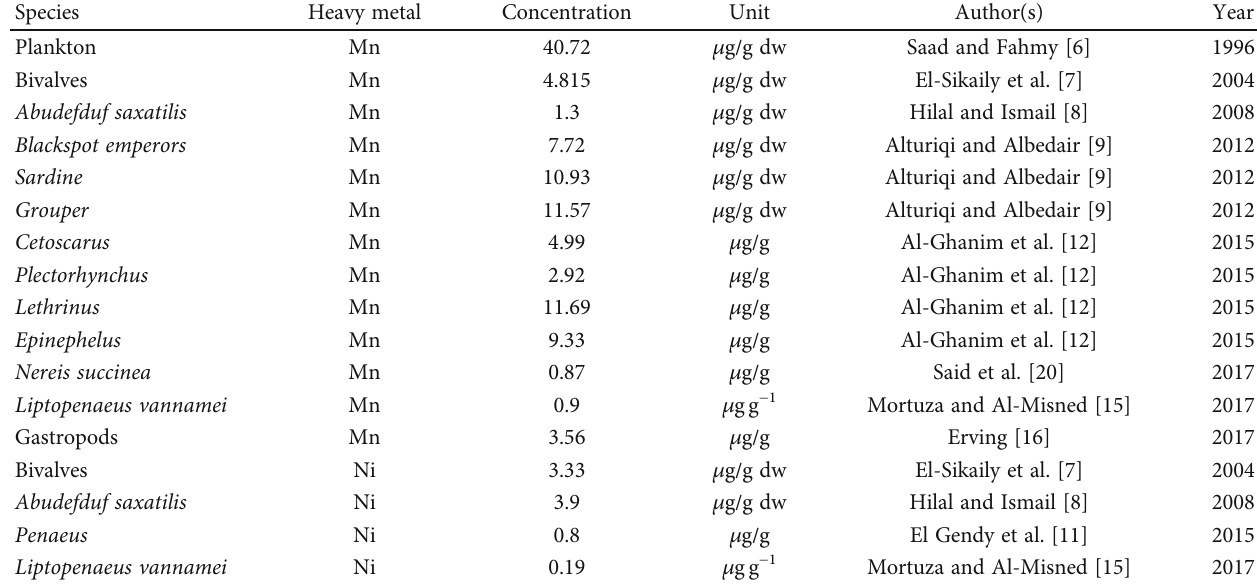
Table 3: Bioaccumulation of manganese and nickel reported from the Red Sea.